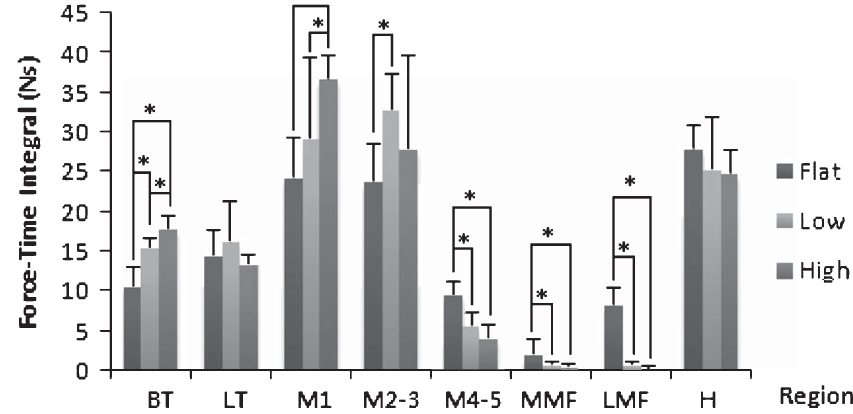
Fig. 3. Peak pressure during jogging with different heel heights. ∗ indicates significant difference ( p <0.05).